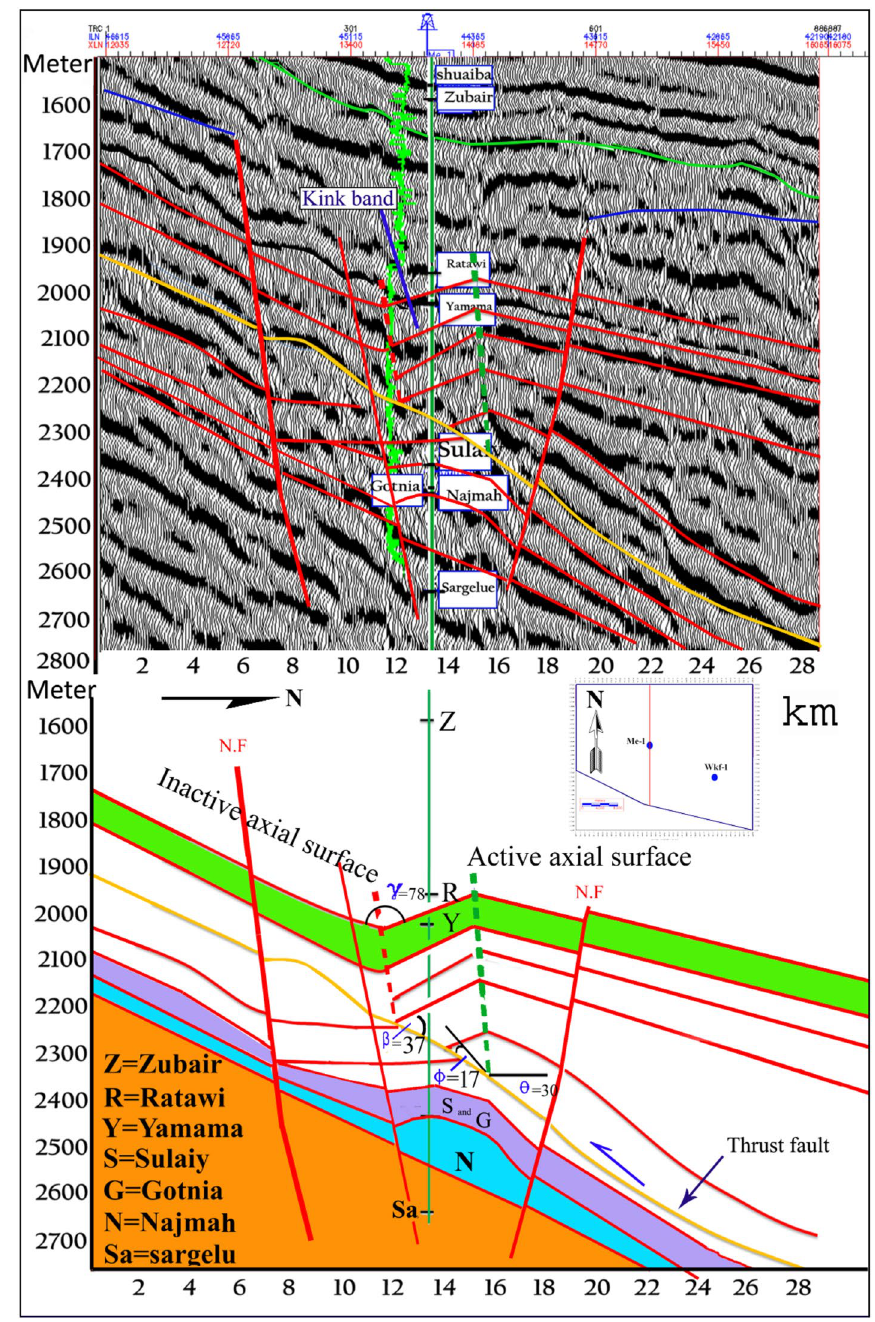
Fig. 11 The interpretation of an anticlinal fault-bend fold imaged in seismic reflection data. The subsurface structures across the inline seismic profile pass across Me-1 well. a The seismic profile across inline 44653. b Shows an anticlinal fault-bend fold at subsurface responsible for the generation mound